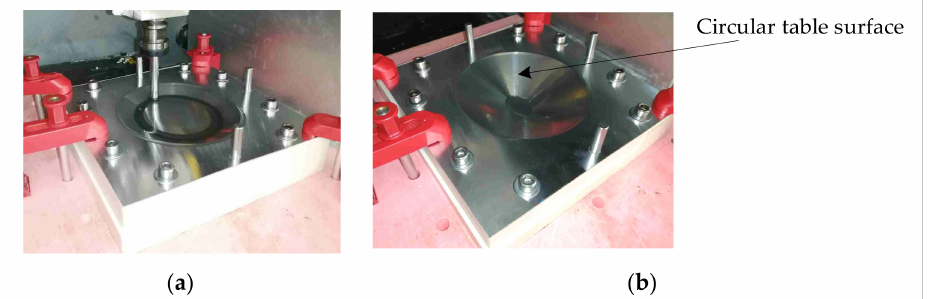
Figure 28. The proposed forming method: ( a ) the first-stage forming process; ( b ) the part formed by the first-stage forming.